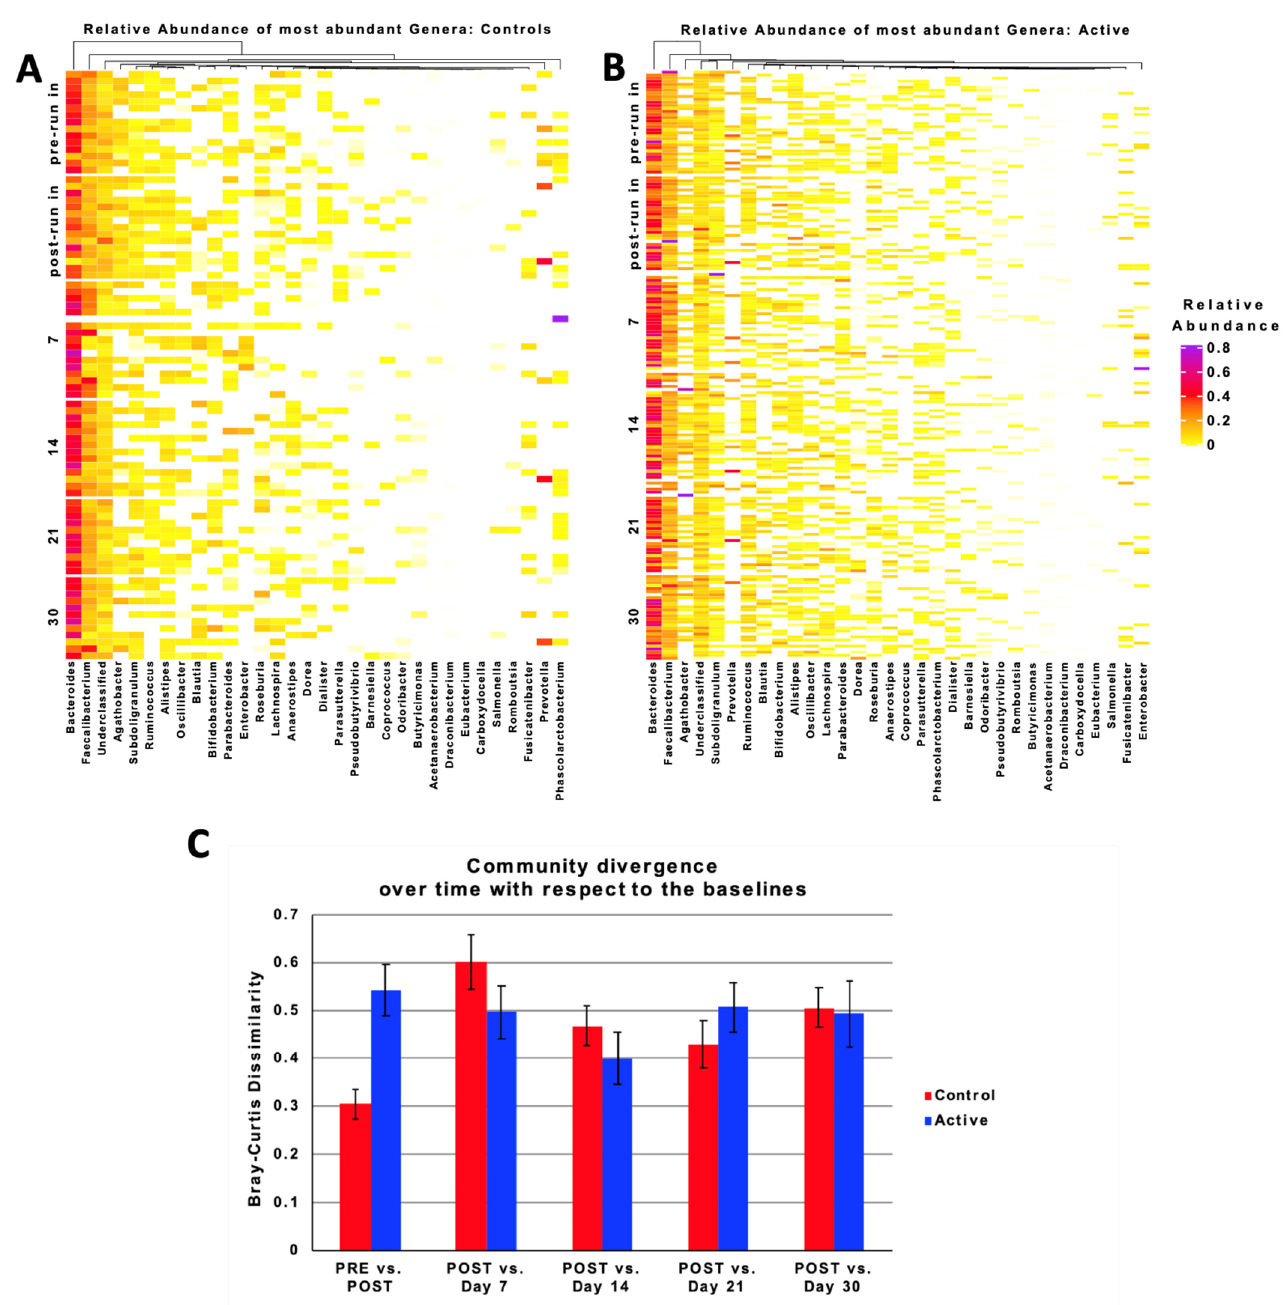
Figure 4. Taxonomic shifts induced by amoxicillin/clavulanate administration with and without BB-12 over time. ( A , B ) Hierarchical dendrogram of participants and their predominant fecal bacterial genera; control group ( A ) and BB-12 (active) group ( B ). The heat map represents the relative abundance (range 0–1; 1 = 100%) of each bacterial genus. The predominant genera are represented along the right x -axis. The legend for the heat map is provided on the right side representing the relative abundance of each bacterial genus within each sample. ( C ) Percent community divergence (Bray–Curtis dissimilarity) over time with respect to the baseline (post run-in, day 0). Control group (blue bar graphs) exhibits overall greater increase in community dissimilarity when compared to BB-12 recipients (red bar graphs).